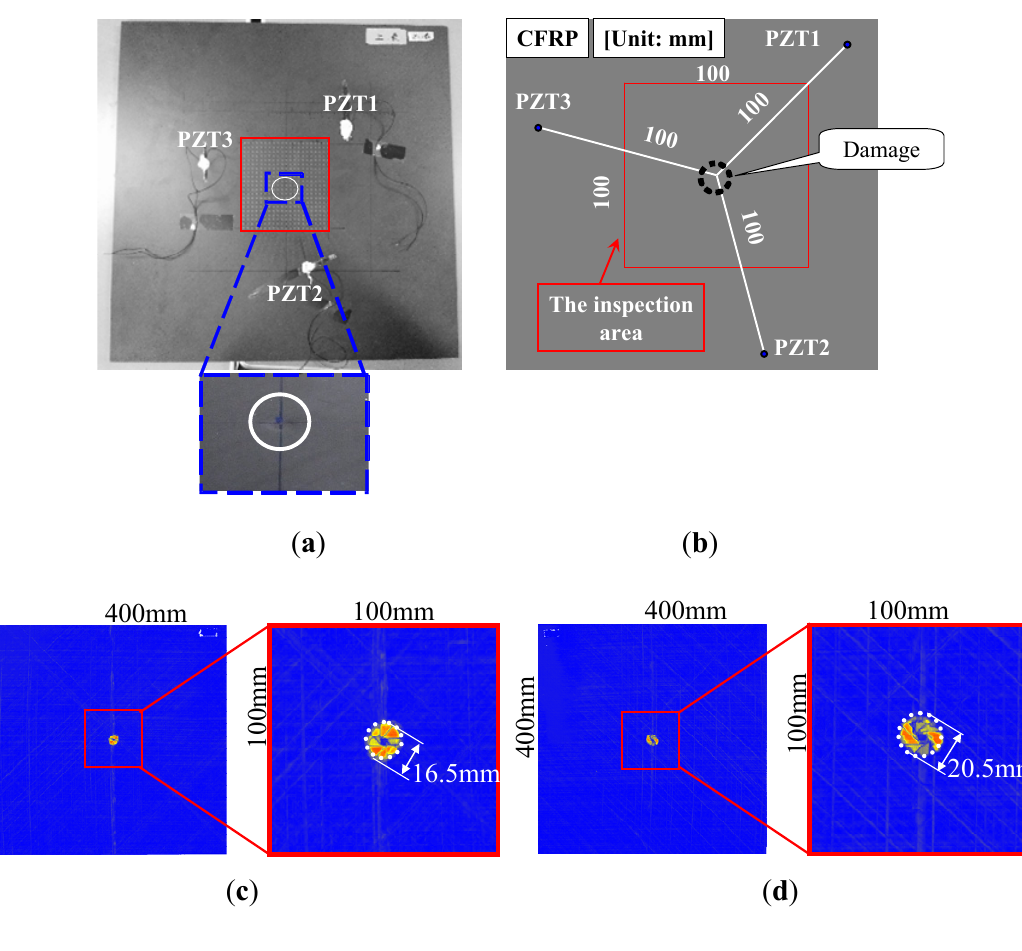
Figure 7. Test specimen (CFRP laminated plate): ( a ) delamination damage; ( b ) position of sensors and damage; ( c ) images of delamination at impacted side; ( d ) images of delamination at opposite side of